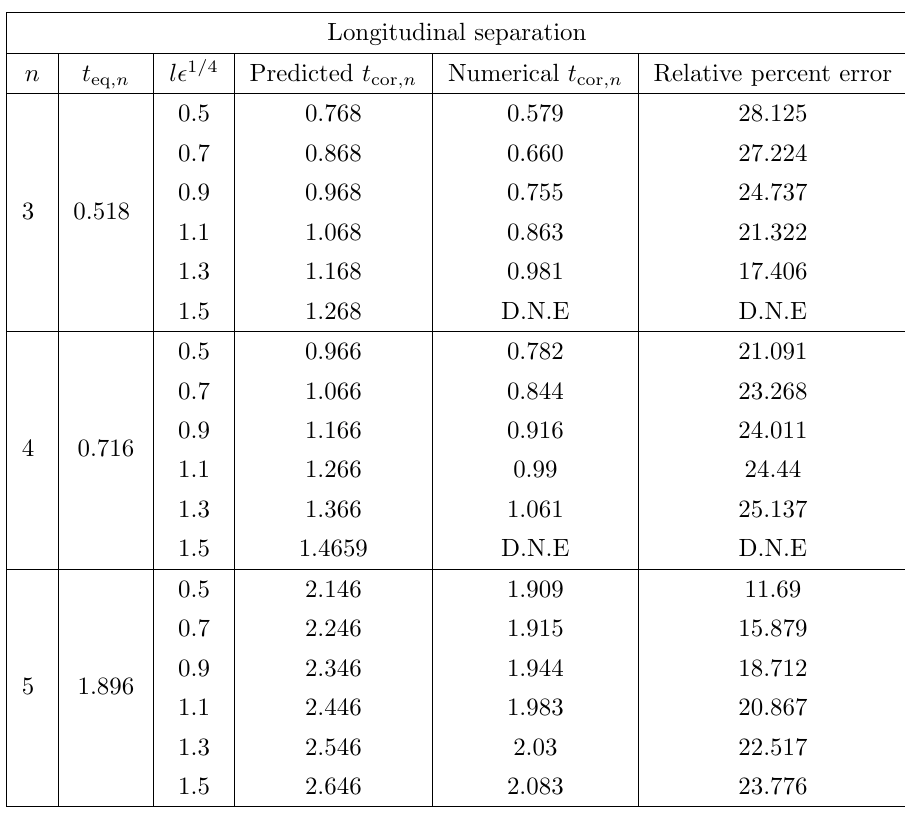
Table 8 . Example equilibrium times of the 1-point functions, t eq in a thermalizing fluid (dual to the evolution towards a magnetic black brane geometry) with and ρ = 0. Entries of D.N.E stand for Does Not Exist, this can be seen in the red curves displayed in the top two graphics of figure 13. The correlation functions of this length scale are lifted above the axis.